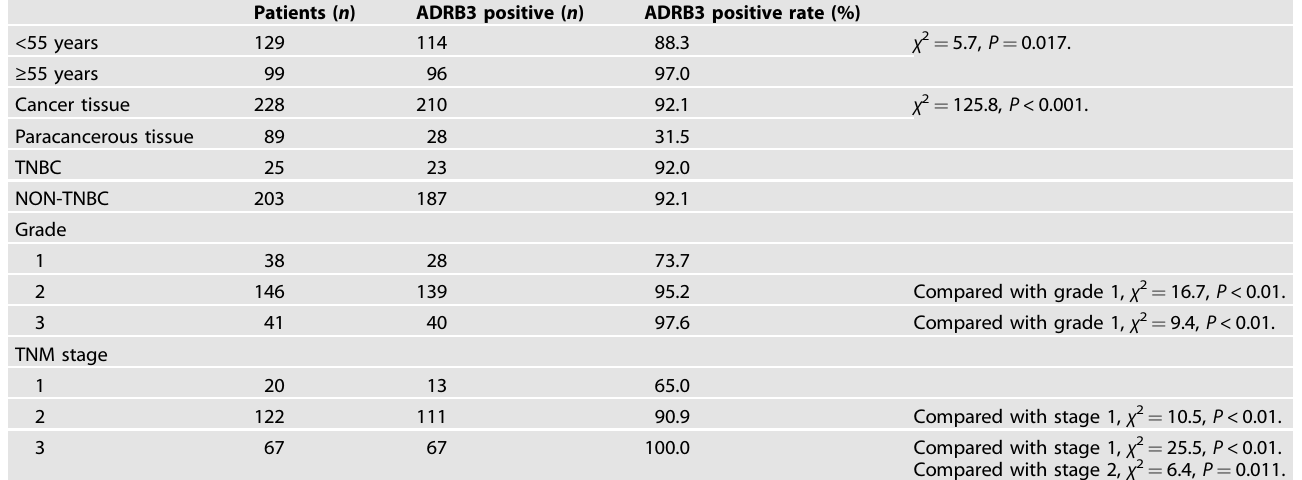
Table 1. Correlations between the expression of ADRB3 and histological grade, AJCC staging (6th) of BC. Patients ( n